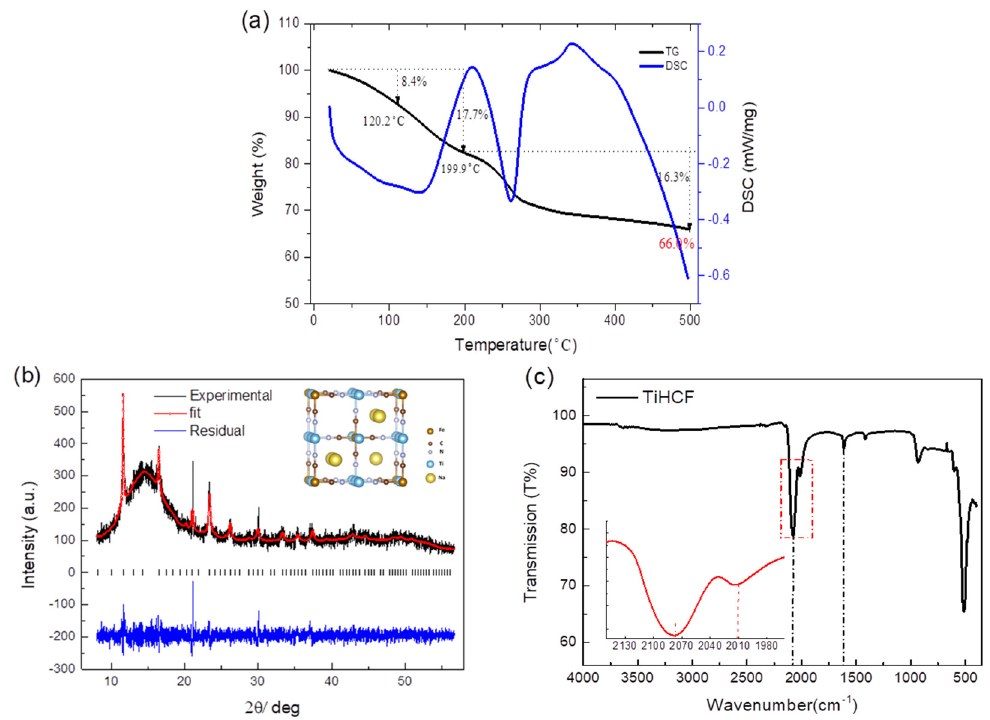
Figure 1. ( a ) Thermogravimetric analysis (TGA) of TiHCF powder and the crystal structure model (inside); ( b ) X-ray powder diffraction (XRPD) pattern and Rietveld refinement on TiHCF powder. The broad peak at around 10–17 degrees is due to the capillary sample holder; ( c ) infrared transmission spectrum of TiHCF powder.